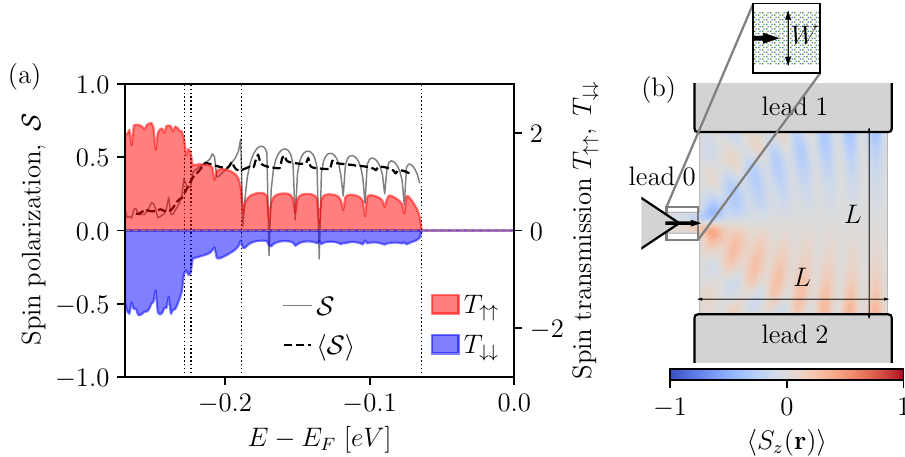
Figure 3: (a) Two-terminal spin polarization of the device shown in panel (b). The S polarization is computed for states transmitted from lead 0 to lead 1 (black line) 〉 taken every 10 points (dashed line) show a saturation as a and rolling average 〈 S function of charge carrier energy E close to 50%. Lines plot spin polarization (with values on the left axis) while individual contributions T ↑↑ , T ↓↓ are shown in color and correspond to the axis on the right edge. The vertical dotted lines indicate the top of the subbands at k ∥ = 0. (b) Scheme of the 3-terminal device used for the tight-binding transport simulations. The scattering region spans a square area of size ( r ) 〉 for E = 50meV, for which L × L , L = 150 a . We also show the spin density 〈 S z spin-polarized hole jets are